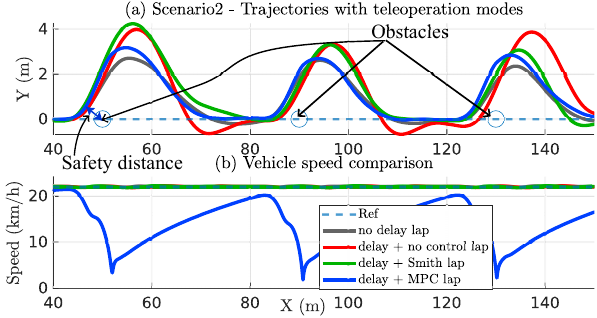
Figure 18. Scenario 2—Trajectories and vehicle speed profile.